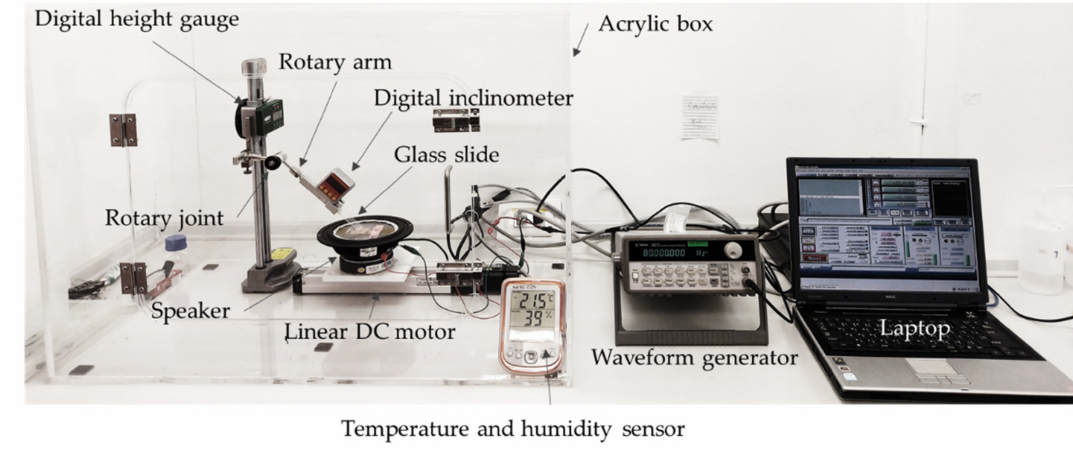
Figure 2. Digital images of the assembled